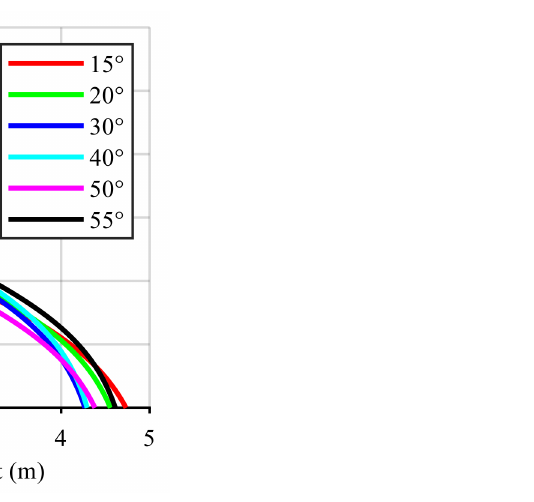
Figure 6. GMFs constructed by DDMA ( top left ), LES ( top right ), and TES ( bottom ) in log10 scale with ERA5 swell height product at incidence angle bins of 15 ◦ , 20 ◦ , 30 ◦ , 40 ◦ , 50 ◦ , and 55 ◦ . Using ERA5 swell height as the ground truth swell